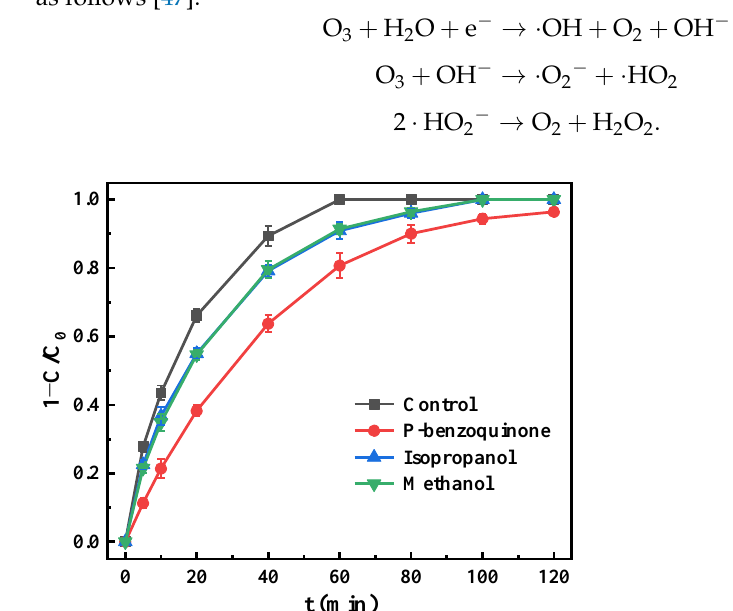
Figure 9. Effect of scavengers on removal efficiency. ([metronidazole] 0 = 15 mg L − 1 , [Na 2 SO 4 ] 0 = 0.05 mol L − 1 , [scavenger] = 0.5 mmol L − 1 , current density = 8.00 mA cm − 2 , dosage = 10.00 g L − 1 , pH = 7, O 3 aeration rate = 0.4 L min − 1 ).